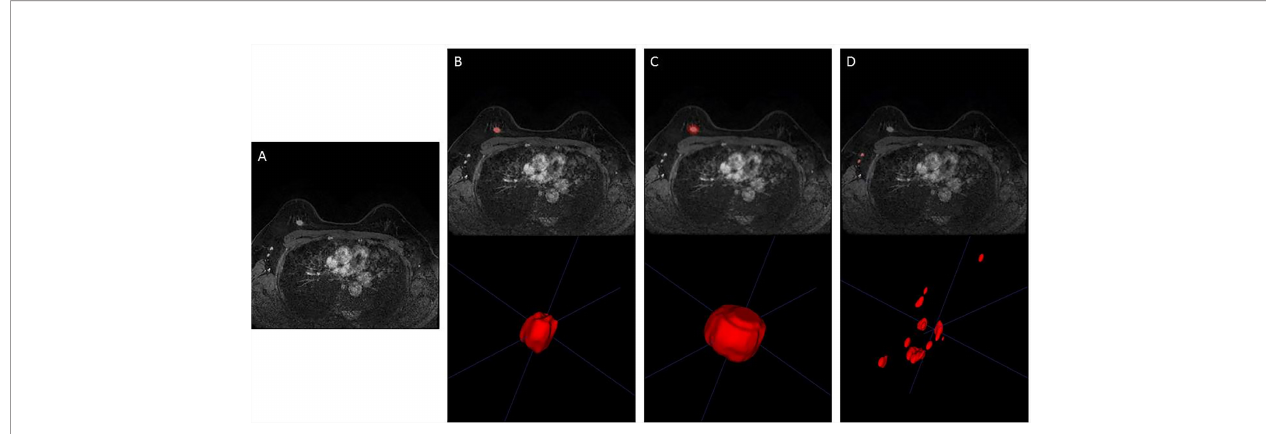
FIGURE 3 | Representative image segmentation. (A) DCE-MRI of a 48-year-old woman with breast cancer in the third phase. (B) Segmentation of breast tumor (ROI of Model 1). (C) Segmentation of intra- and peri-breast tumor (ROI of Model 2). (D) Segmentation of ALN (ROI of Model 3). DCE-MRI, dynamic contrast- enhanced MRI; ROI, region of interest; ALN, axillary lymph